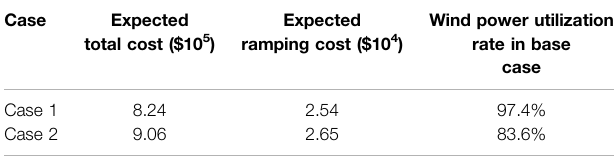
TABLE 1 | Comparison of scheduling results of electricity systems in Case 1 and